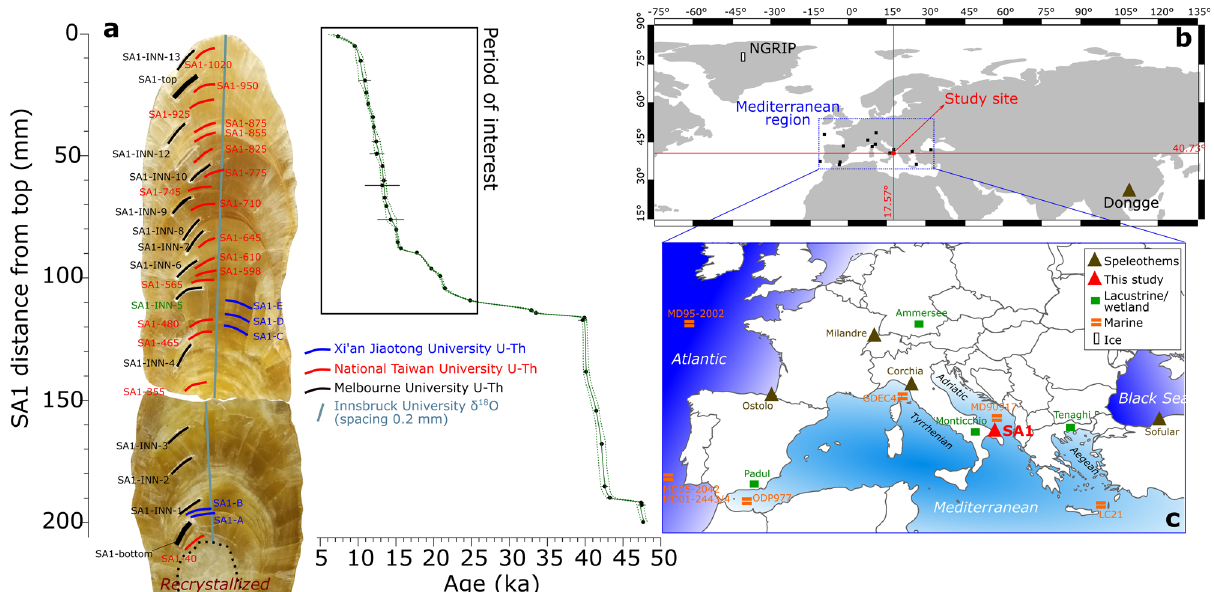
Fig. 1 Sample, analyses and study site. a SA1 stalagmite and analyses accomplished in this study. Coloured bars refer to U-Th dating at Xi ’ an Jiaotong (blue), National Taiwan (red) and Melbourne (black) Universities, while the blue line marks δ 18 O analyses (methods) carried out at Innsbruck University. The age model is reported with dots and 2 σ error bars (indicating the U-Th ages) and their relative interpolation (green line = average model; dotted lines = propagation of ±2 σ uncertainties). b , c Study site and other records discussed in the